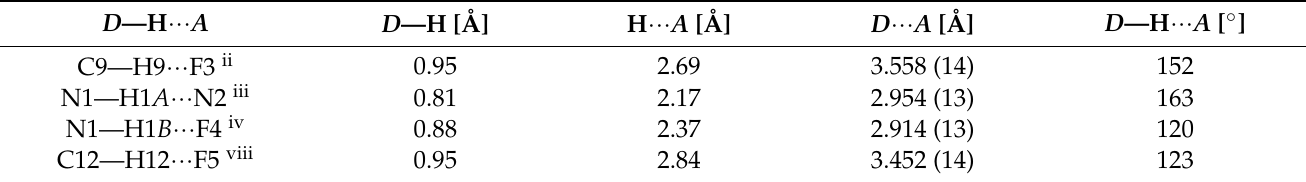
Figure 3. ( a ) Single-stranded H-bonded polymer system; ( b ) the lattice, viewed along the [100] direction, showing adjacent non-covalently linked polymer systems running along the [110] and [1–10] directions. Table 2. Hydrogen bond geometry in [Ag 2 L 2 ](SbF 6 ) 2